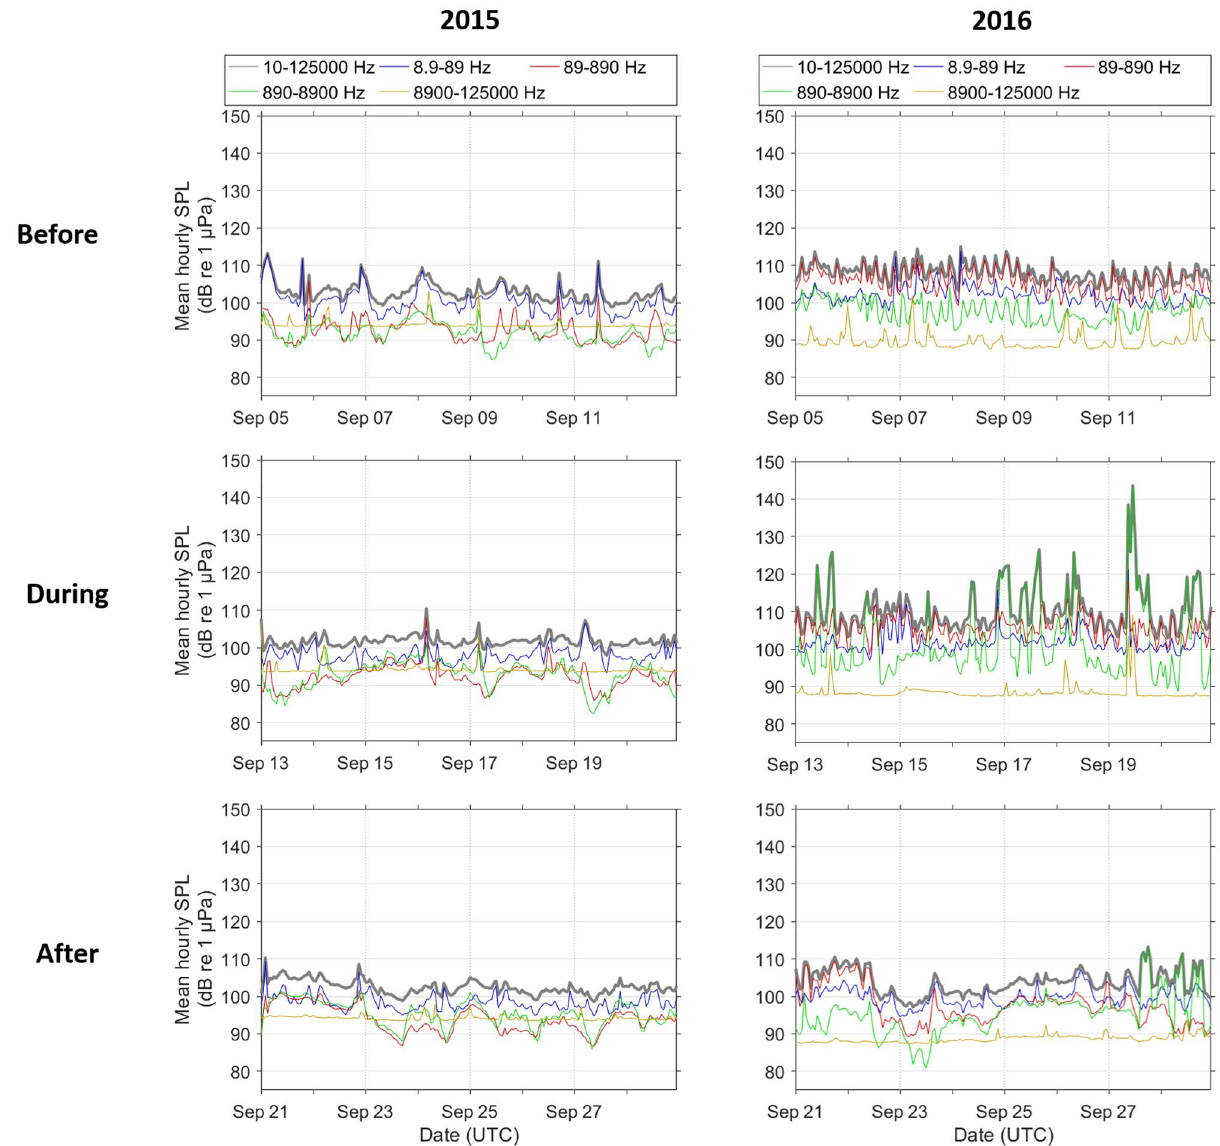
Figure 8. Mean hourly frequency band ambient sound pressure levels (SPL) recorded over the 8-day periods before (Sep 5th–Sep 12th), during (Sep 13th–Sep 20th), and after (Sep 21st–Sep 29th) the period in which sonar signals from the CF16 exercise were detected in 2016 (right) and the corresponding dates in 2015